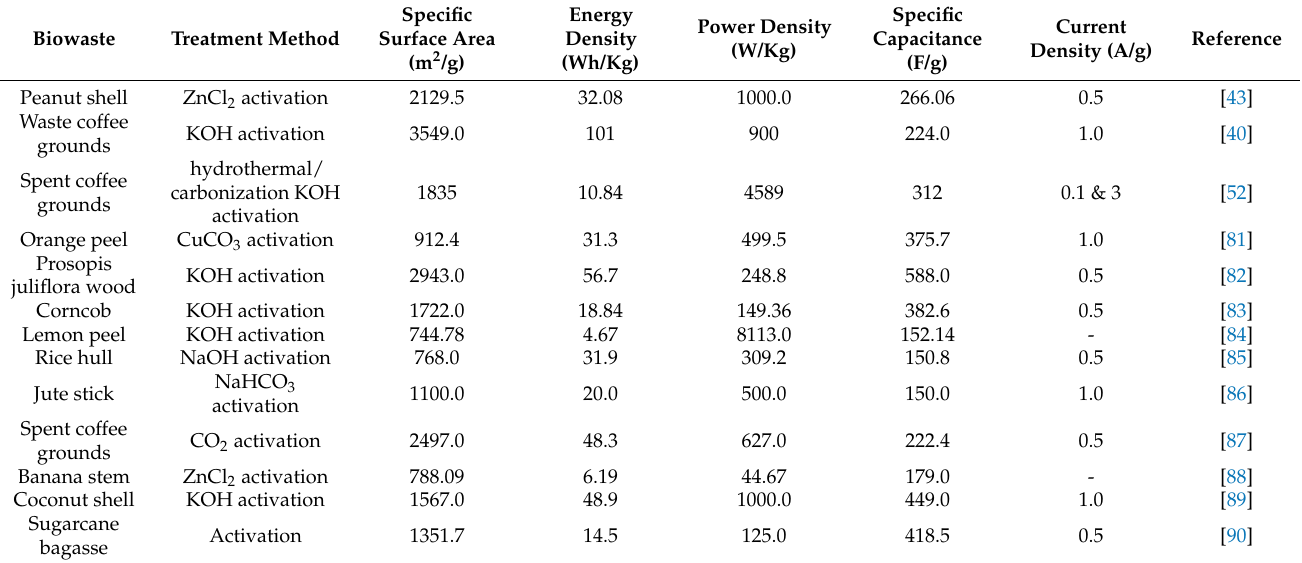
Table 4. Performance of some reported biowaste-based activated carbon for supercapacitor applica- tions.